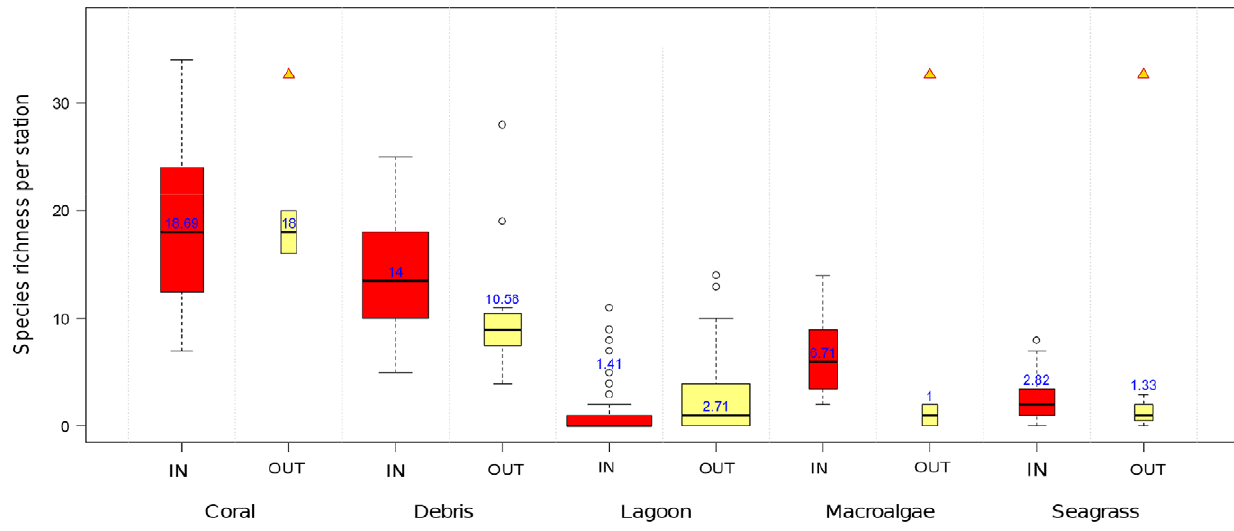
Figure 7. Species richness per station as a function of habitat (see Table 4 for habitat definition) and protection status (IN versus OUT). On each boxplot, boxes showed the interquartile (0.25, 0.75) ranges; whiskers extended to the data point at # 1.5 times the box length away from the box; values outside this range were represented by dots. Triangles indicated boxplots with less than 5 data.